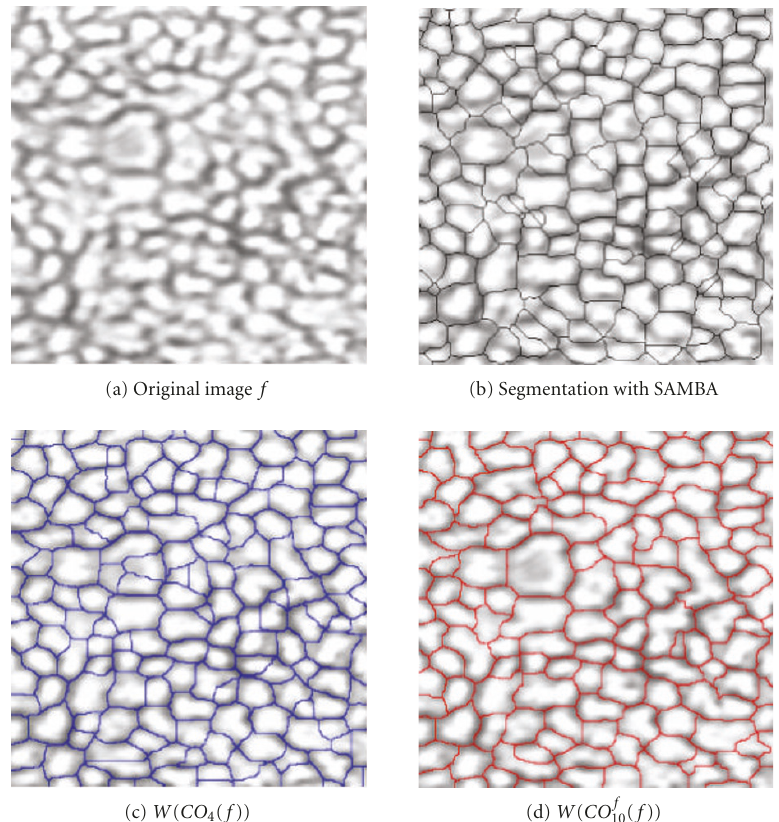
Figure 9: Segmentation of human endothelial cornea cells (a). The process achieved by the LANIP-based morphological approach (d) pro- vides better results (from the point of view of ophthalmologists) than the SAMBA software (b) or the correspondent classical morphological approach